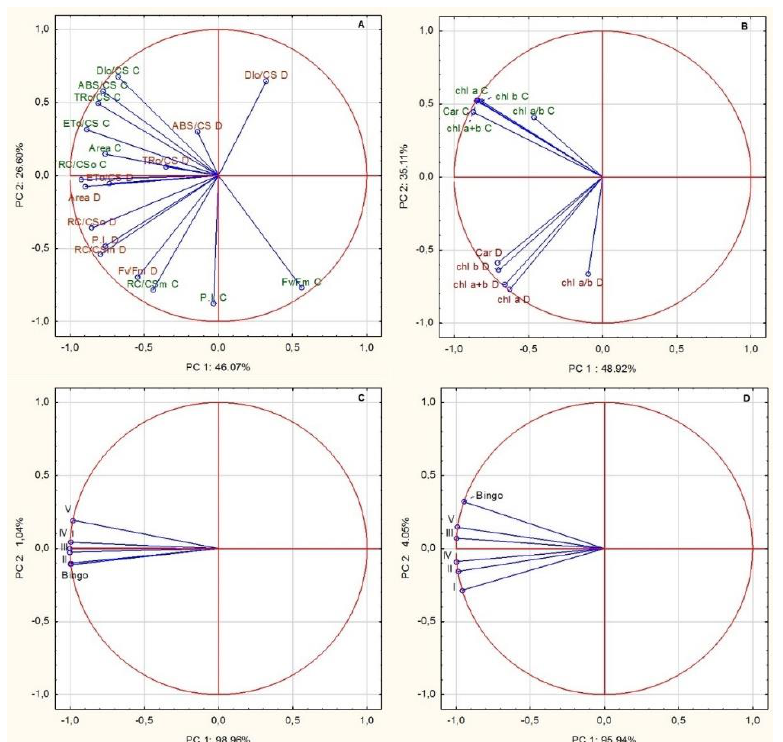
Figure 9. Biplot based on the first two principal component axes (PC 1 and PC 2); chlorophyll a fluorescence parameters ( A ) and photosynthetic pigments ( B ) dependent on the treatment; distribution of cv. Bingo and OMA lines based on the chlorophyll a fluorescence parameter ( C ) and ( D ) photosynthetic pigments.